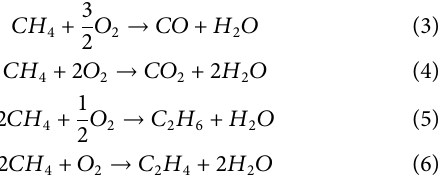
Frontiers in Chemistry |